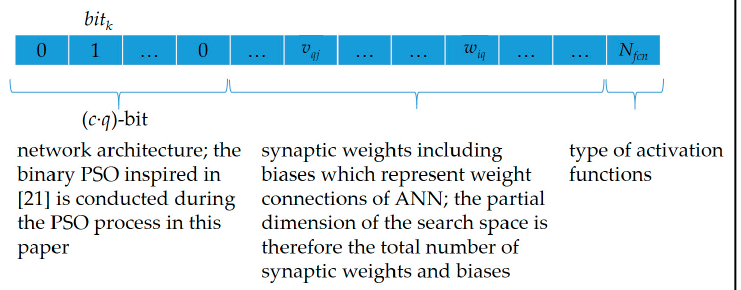
Figure 6. Codification of the ANN encoded into each particle for an ANN designed through the PSO process.